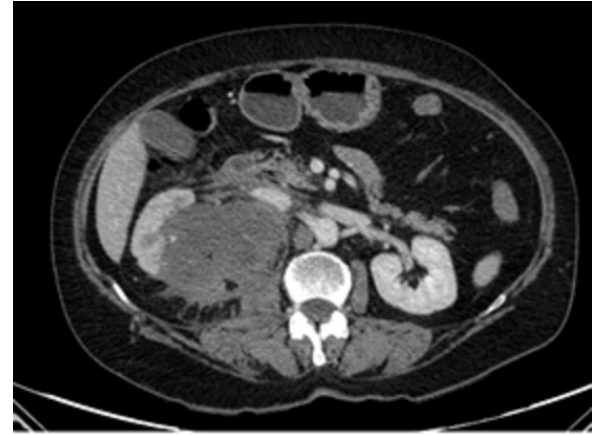
Figure 1: CT scan of the abdomen demonstrates the right renal mass.